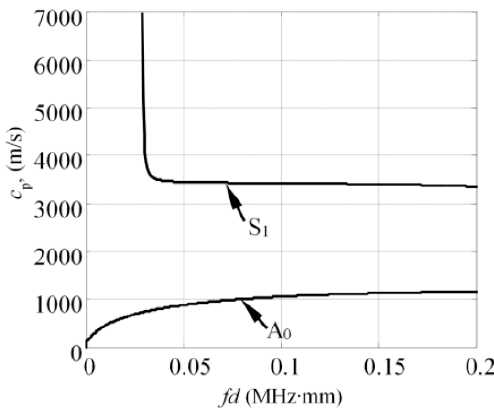
Figure 3. The phase velocity dispersion curves of 4 mm thick and 70 mm wide glass fiber reinforced plastic (GFRP) plate, calculated using the semi analytical finite element method.